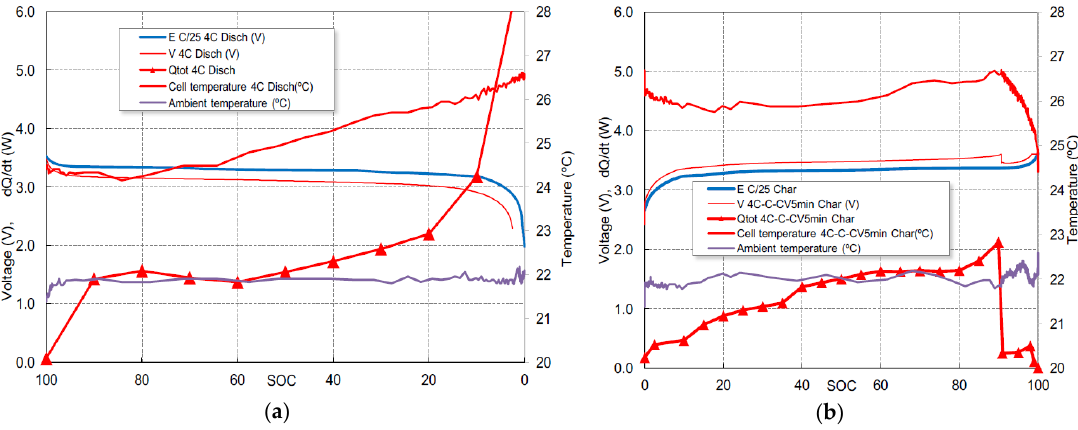
Figure 4. ( a ) Voltages, case temperature and total heat evolution profile versus state of charge of the cell, 4C discharge; and ( b ) 4C-1C-CV 5 min charge.